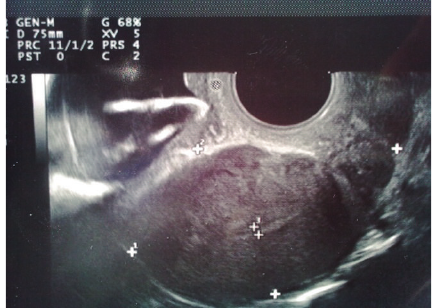
Figure 3: Cystoscopic view of IUD and bladder stone.